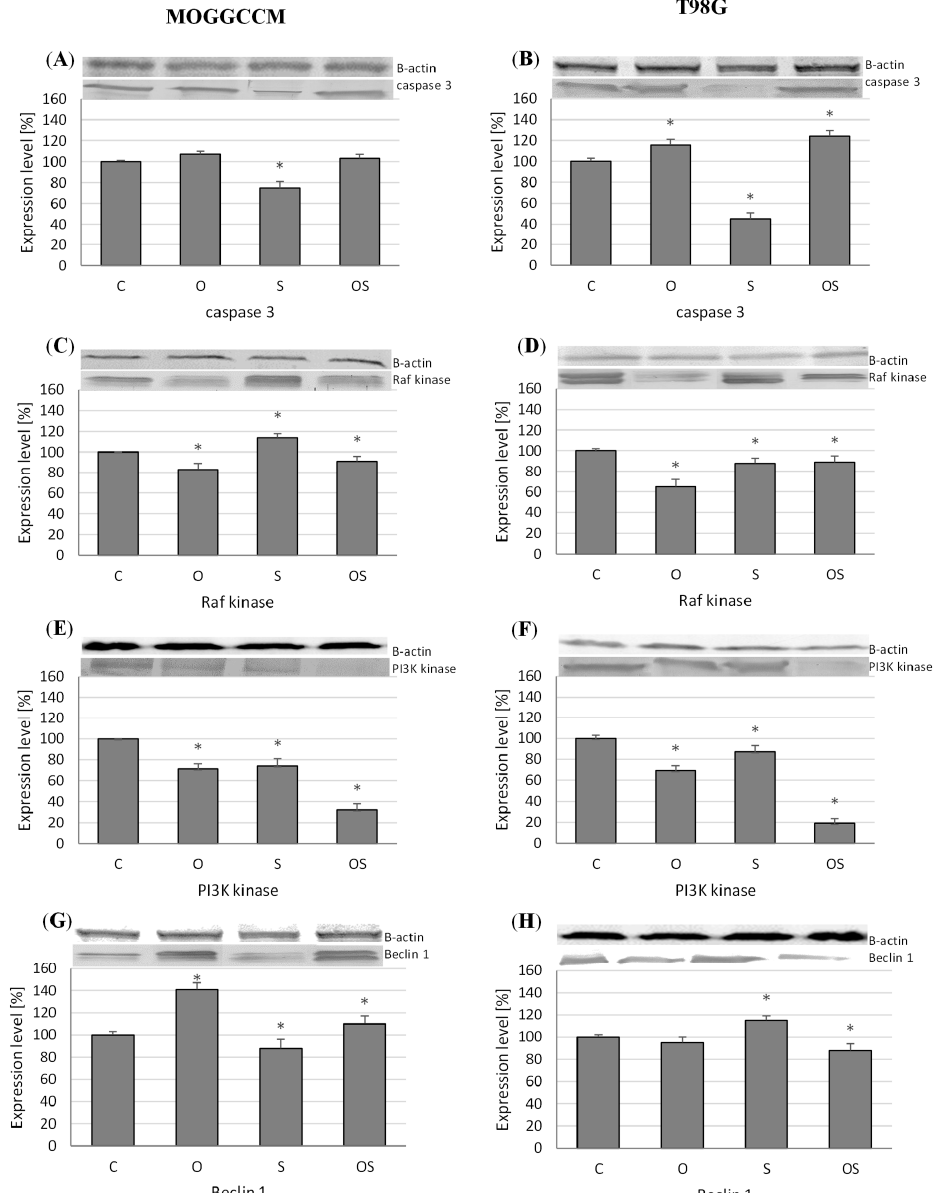
Figure 4. E ff ect of osthole, sorafenib and combined treatment with both drugs on the expression of caspase 3 ( A , B ), PI3K (Phosphoinositide 3-kinase) ( C , D ), Raf (Rapidly Accelerated Fibrosarcoma) ( E , F ), and Beclin 1 ( G , H ) in the MOGGCCM ( A , C , E , F ) and T98G ( B , D , G , H ) cell lines. C—control, O—osthole, S—sorafenib; * p <